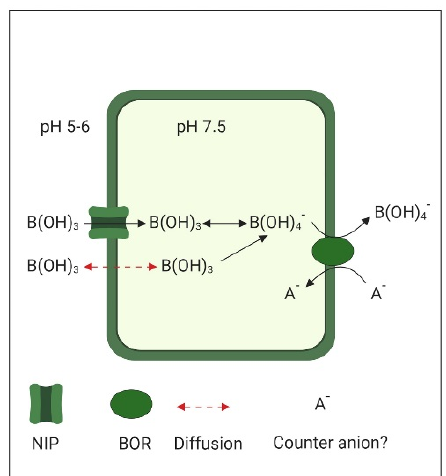
Figure 2. Boron (BOR) transport in plant cells. Neutral boric acid, the main form in the slightly acidic apoplast, can enter either by diffusion or through the Nodulin26-like Intrinsic Protein (NIP). The near to neutral pH of the cytoplasm favors the formation of borate, which is exported by BOR transporters.